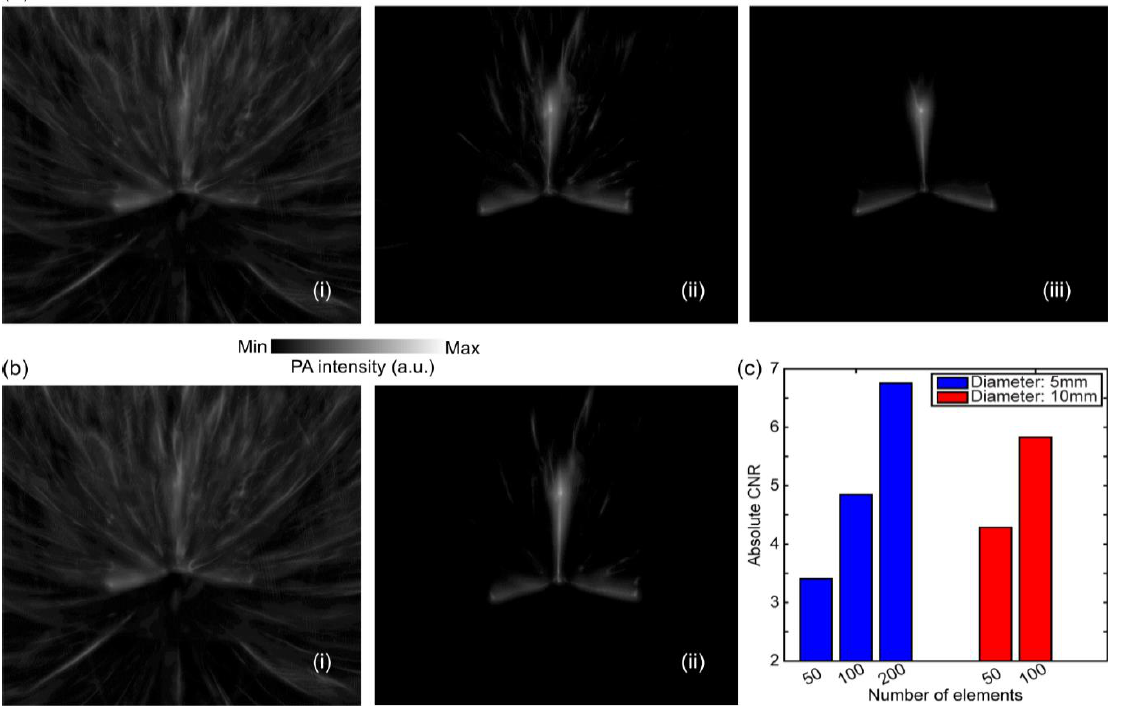
Figure 4. Simulated reconstruction of three-leg phantom using ( a ) 5-mm diameter active area transducer with (i) 50, (ii) 100, and (iii) 200 elements; ( b ) 10 mm diameter active area transducer with (i) 50 and (ii) 100 elements; and ( c ) absolute contrast to noise ratio of different numbers of elements with 5- and 10-mm diameter transducers.